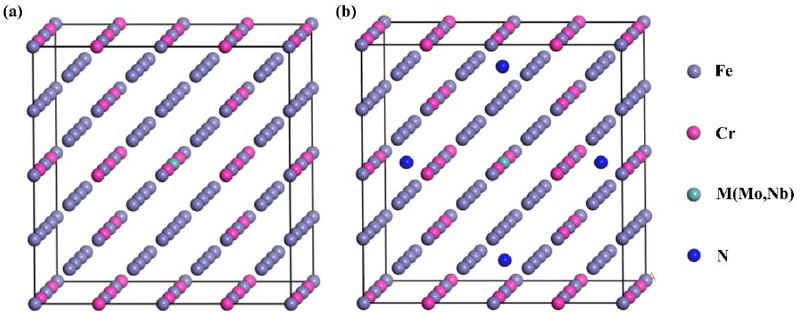
Figure 2. The crystal structure of ( a ) Fe105Cr22M and ( b ) Fe105Cr22MN4 (M = Mo or Nb) solid